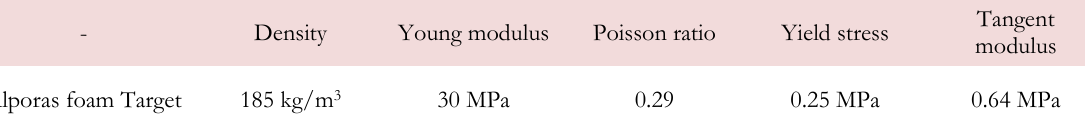
Table 9: Properties of Alporas foam.